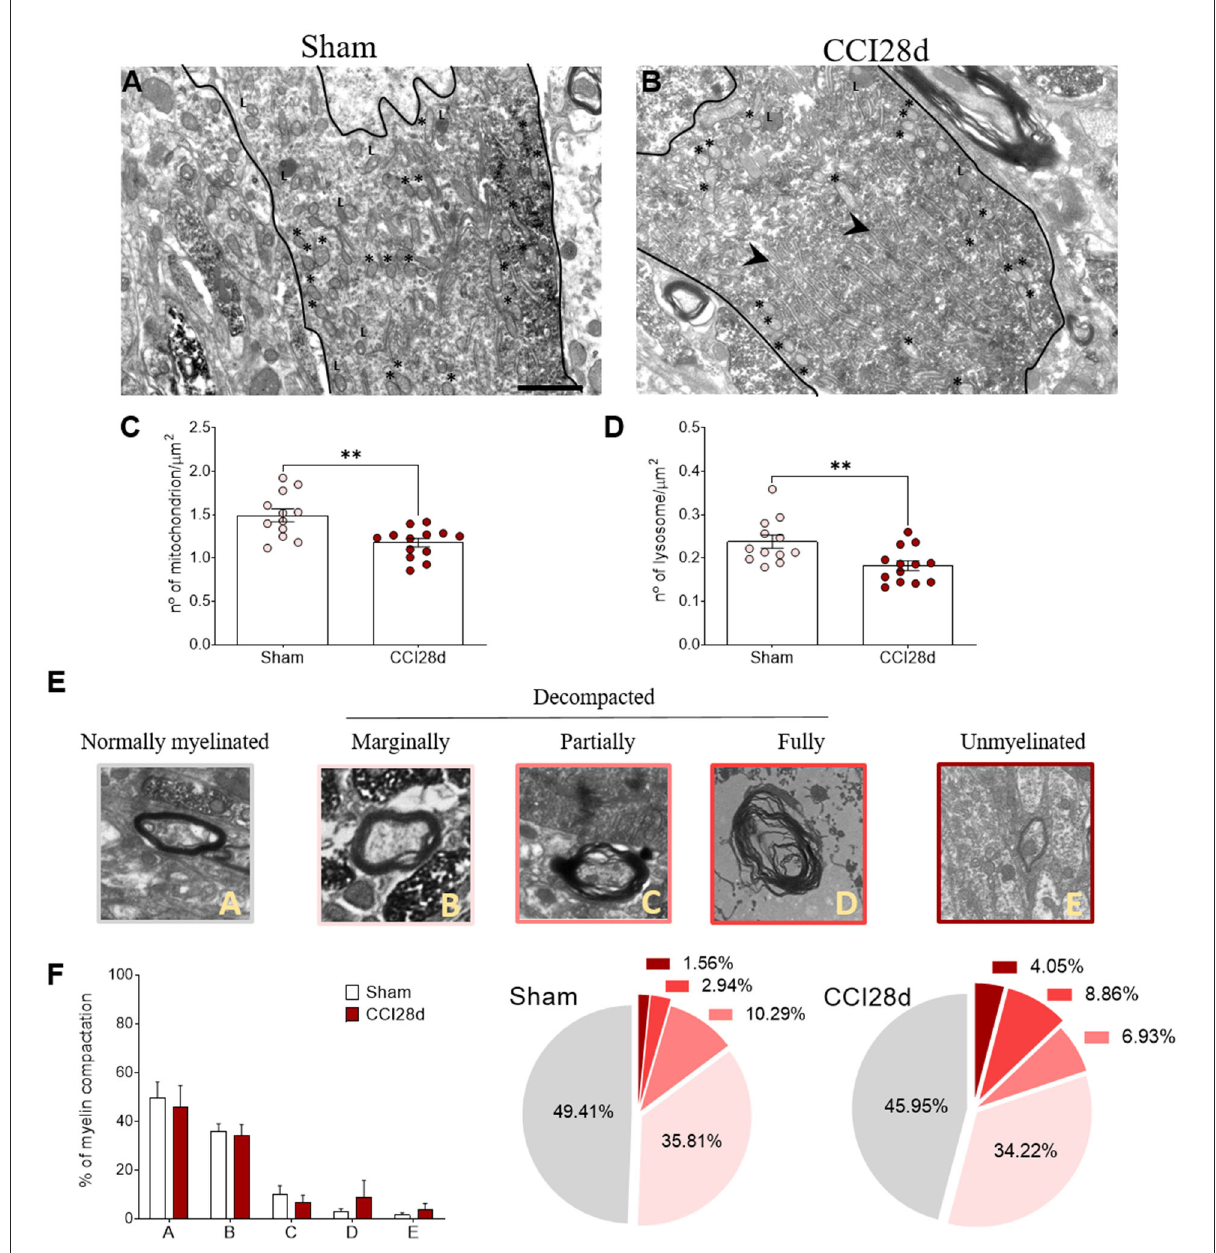
FIGURE5 Ultrastructural studies of noradrenergic LC neurons in neuropathic pain rats. Representative electron microscopy images of (A) Sham and (B) CCI28d rats. The asterisks indicate mitochondria and the arrowheads point to the dilated ER: L, lysosome. Scale bar: 2 µ m. (C,D) Quantification of the number of (C) mitochondria and (D) lysosomes. (E,F) Representative images and quantification of the relative myelin compaction scored from A to E as axons with normal myelin (A) , marginally (B) , partially (C) , fully decompacted (D) , and unmyelinated (E)